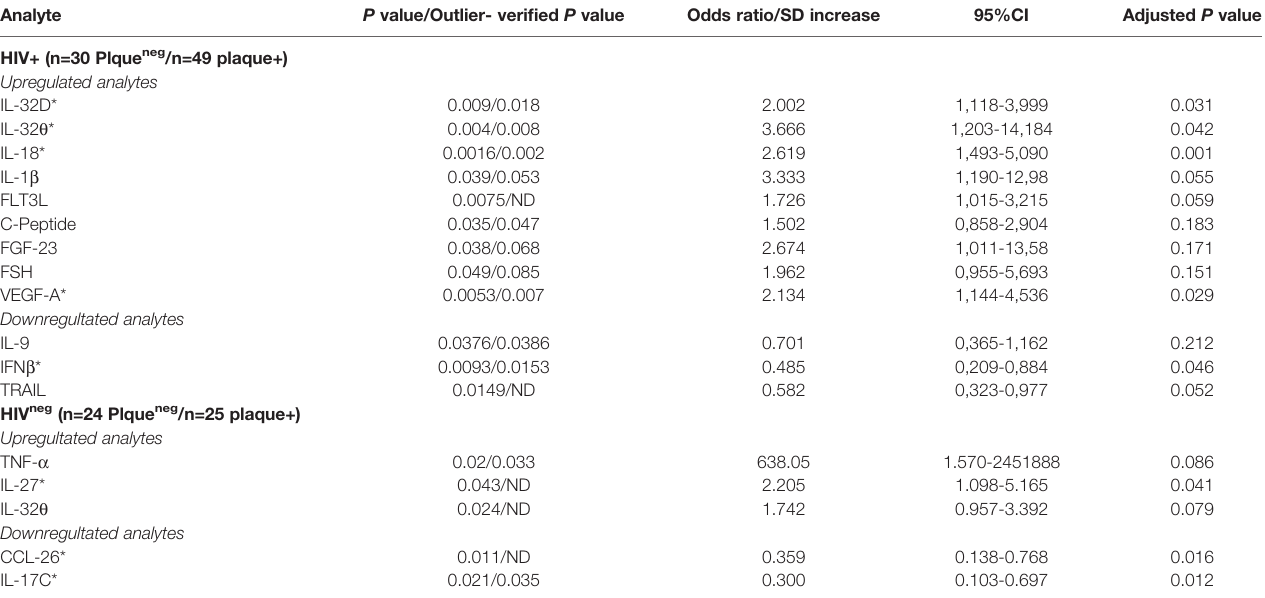
TABLE 2 | Veri fi cations of outliers and adjustment for age, smoking and statin treatment for the differentially expressed analytes between individuals with/without coronary artery atherosclerosis. Analyte P value/Outlier- veri fi ed P